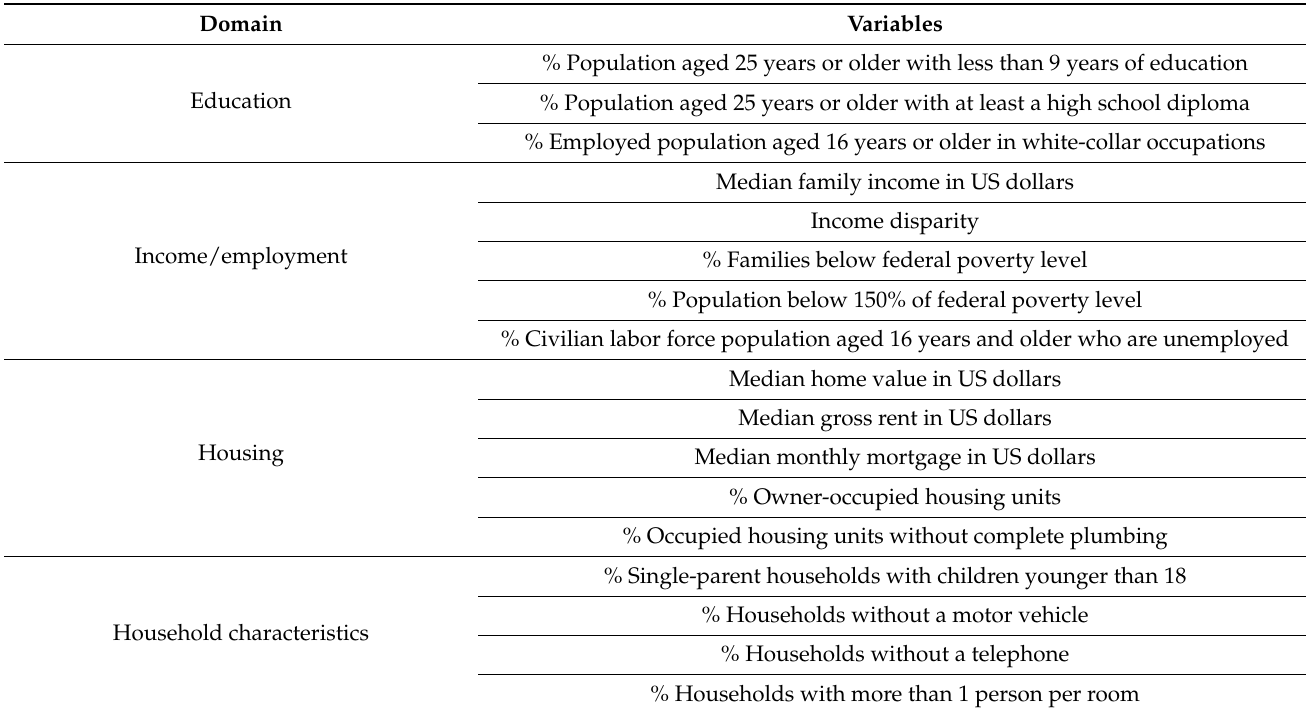
Table 1. Factors in the Social Deprivation